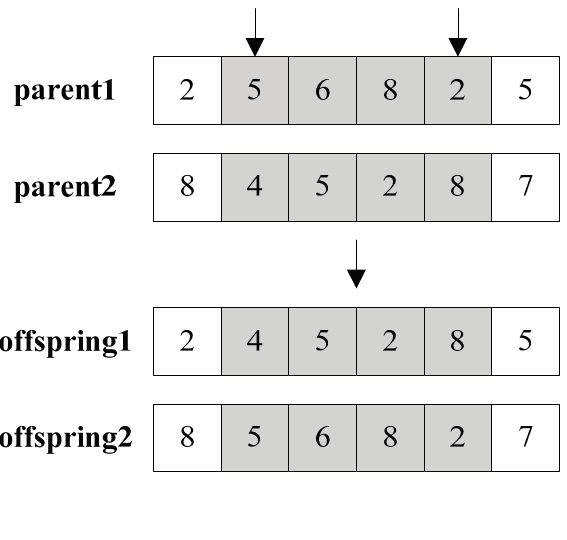
Figure 4. Illustration of crossover